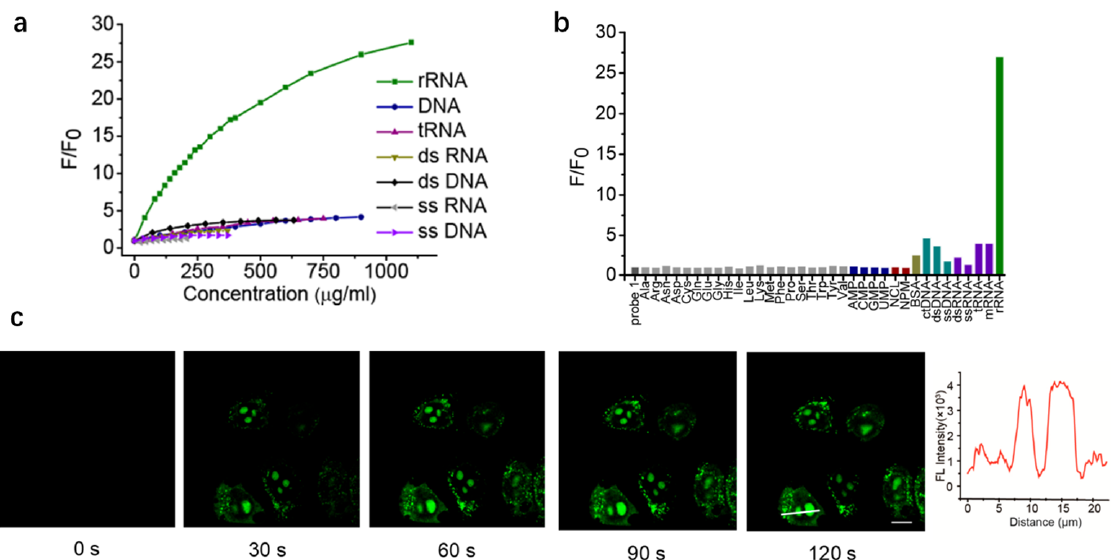
Figure 15. ( a ) Fluorescent titration of probe 15 at 10 µ M with the addition of rRNA. ( b ) Selectivity of probe 15 (10 µ M) versus different species including 20 kinds of amino acids (200 µ M), four kinds of mononucleotide acid (200 µ M), two nucleolus proteins nucleolin (NCL) (10 µ M), and nucleophosmin (NPM) (10 µ M), BSA (200 µ M), ctDNA (1200 µ g/mL), synthesized dsDNA (630 µ g/mL), synthesized ssDNA (370 µ g/mL), synthesized dsRNA (370 µ g/mL), synthesized ssRNA (206 µ g/mL), tRNA (750 µ g/mL), mRNA (100 µ g/mL) and rRNA (1000 µ g/mL) in 20 mM PB at pH 7.2. ( c ) Time- dependence (0 s, 30 s, 60 s, 90 s, 120 s) CLSM images of HeLa cells incubated with probe 15 at 5 µ M ( λ ex = 488 nm, λ em = 515–565 nm). Bottom right: fluorescence intensity profile of selected area labeled with a white bar. Scale bar: 10 µ m. Reproduced from [54] with permission from the American Chemical Society, Copyright 2019.